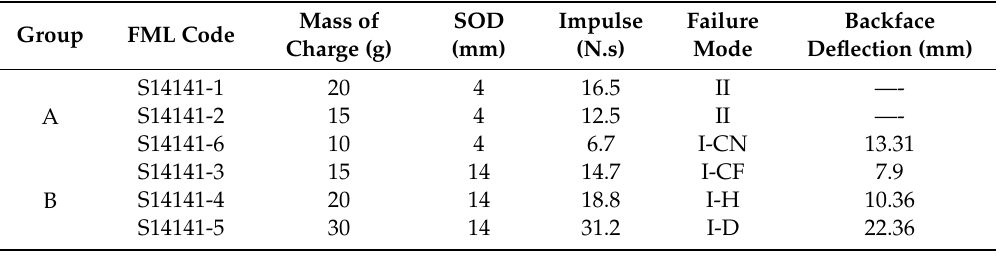
Table 2. Stand-o ff distance, weight of explosive, the calculated impulse for the corresponding mass of explosive, the maximum back face deflection, and the failure